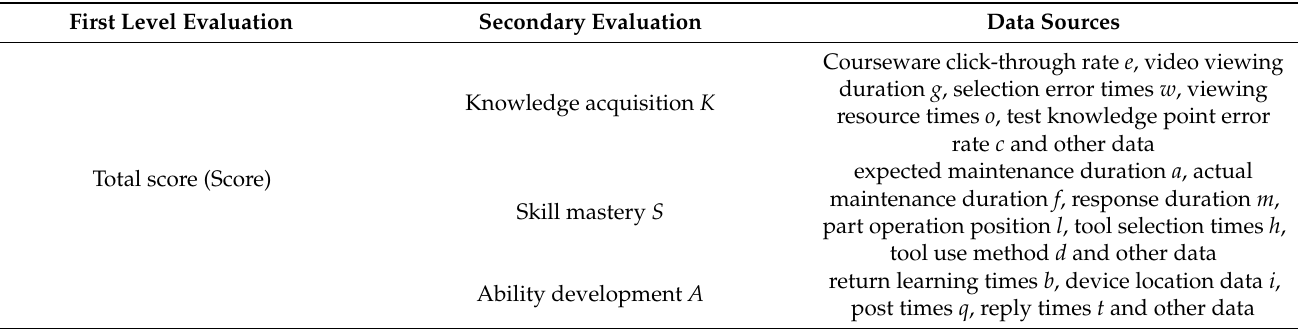
Table 3. Process evaluation index